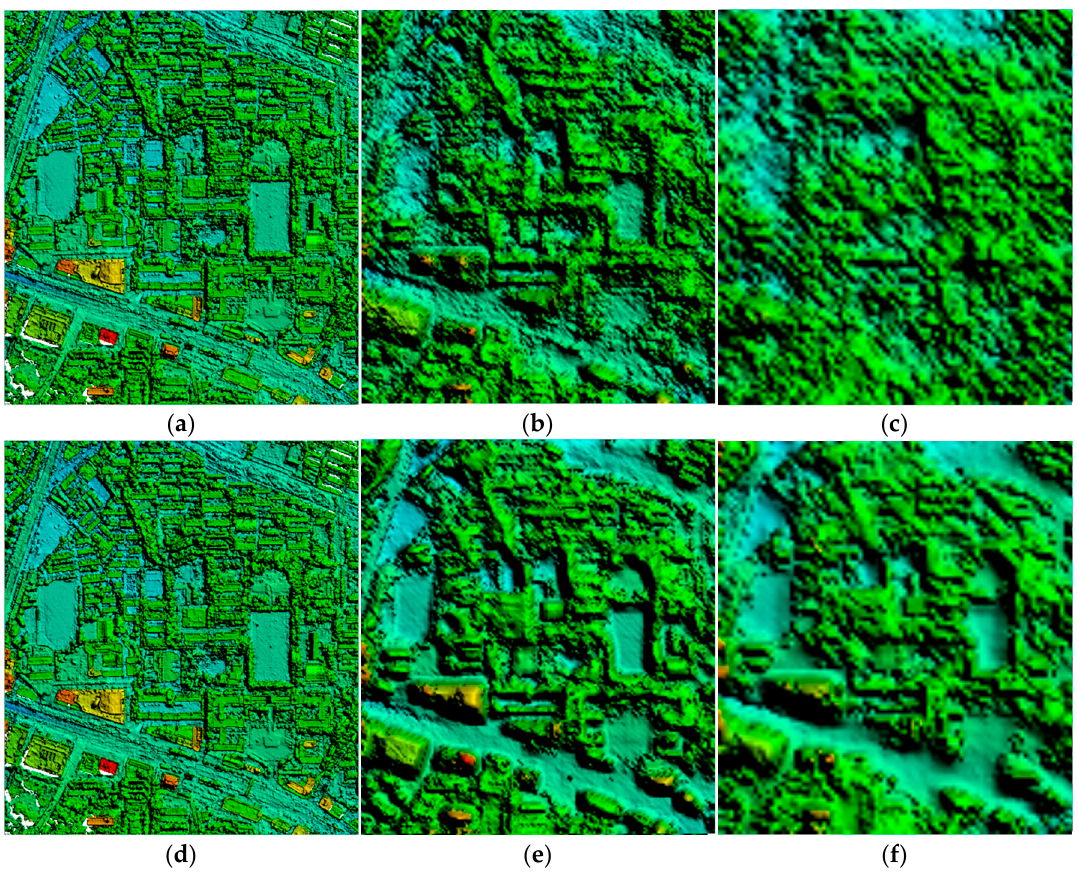
Figure 10. Generated DSMs with different GSDs. ( a – c ) Results of the traditional method using a constant elevation step same with the GSD; and ( d – f ) results of the proposed method using an adaptive elevation step. The GSDs of (a,d), (b,e) and(c,f) are 0.5m, 5m, and 10m, respectively.